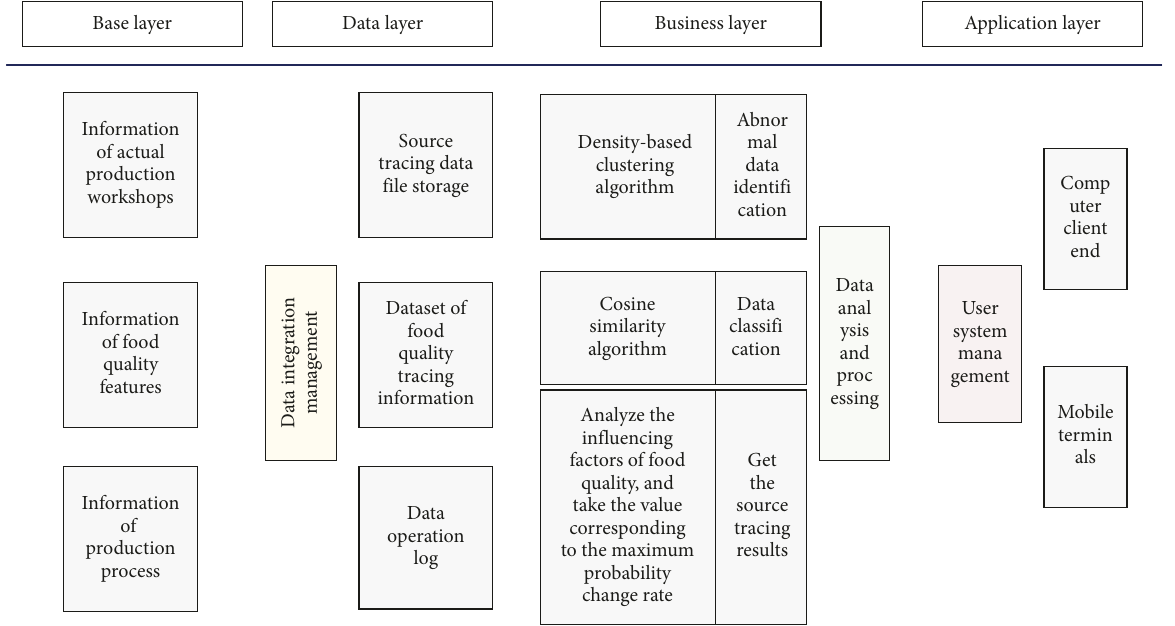
Figure 4: Framework of food quality source tracing